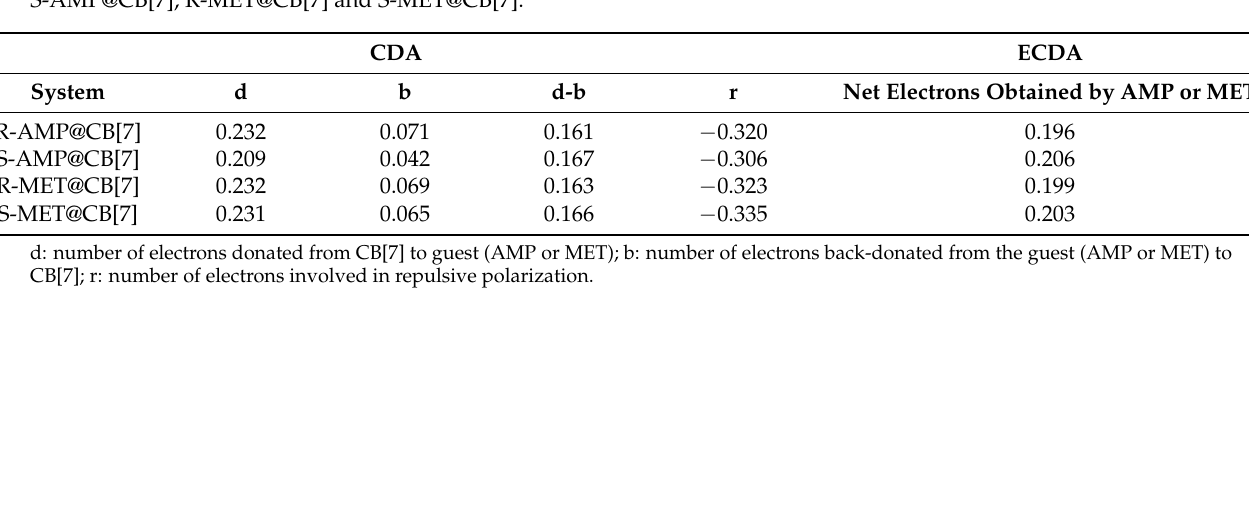
Table 5. Charge decomposition (CDA) analysis and extend charge decomposition analysis (ECDA) of CB[7],